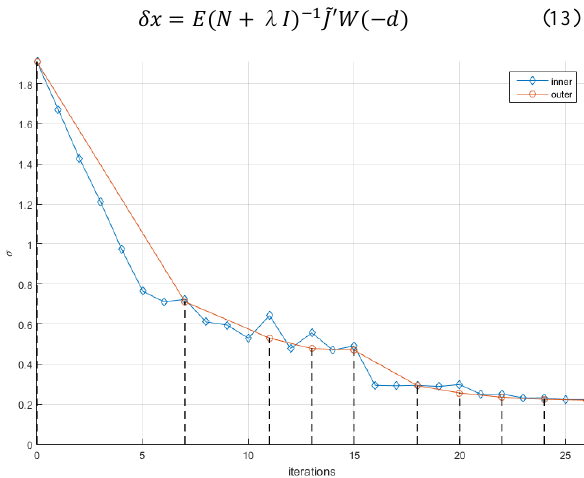
Figure 3. Plot of convergence behavior. Residuals are plotted against inner iterations (blue). The dashed vertical lines and orange curve indicate nine outer iterations. After the fourth outer iteration the full camera model is applied, causing a stronger improvement. Outlier removal is triggered after the sixth outer